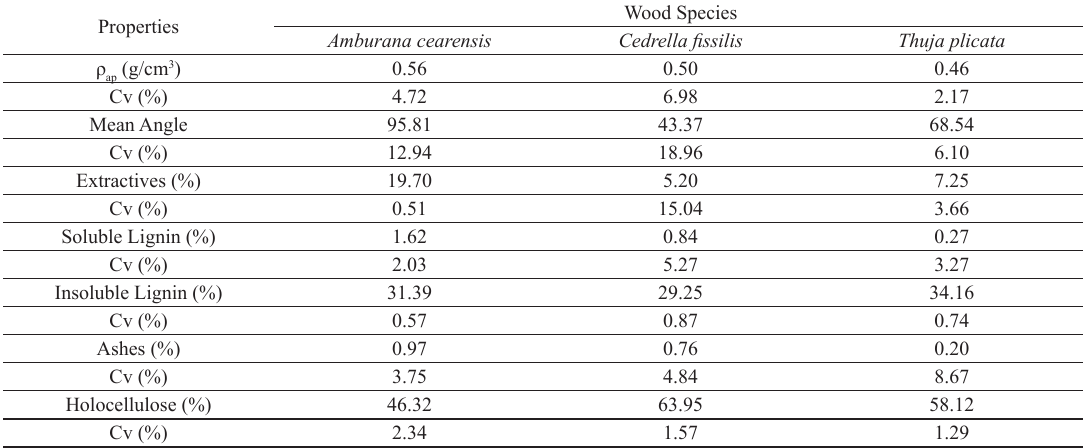
Table 3. Physical and Chemical results for Wood